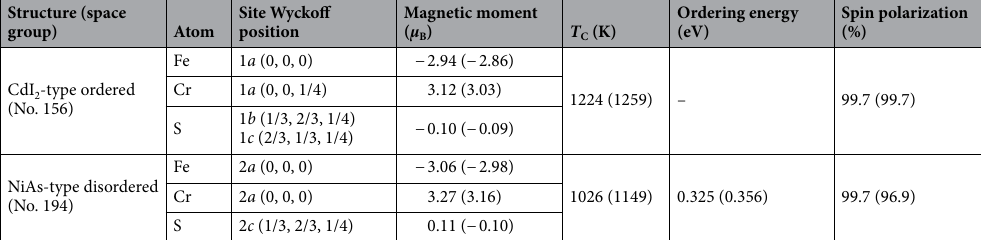
Table 1. Physical properties of CdI 2 -type ordered and NiAs-type disordered (CrFe)S compound. The magnetic moment, the Curie temperature ( T C ), ordering energy (i.e., the difference in total energy between the CdI 2 -type ordered structure and NiAs-type disordered structure), and spin polarization were calculated by the KKR